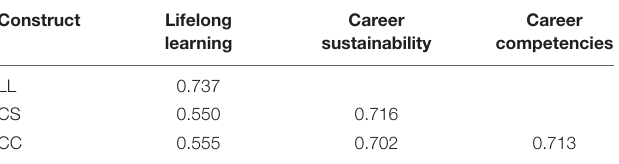
TABLE 2 | Discriminant validity analysis (Fornell and Larcker).